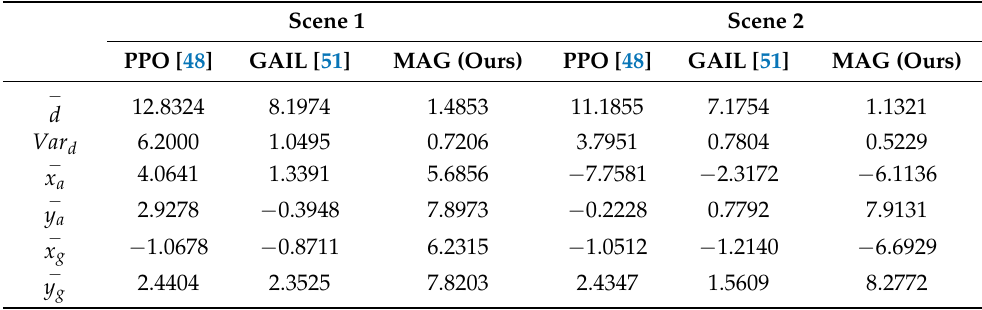
Table 4. Comparison of tracking performance after AUV training 20,000 times using PPO, GAIL, and MAG in Scenes 1 and